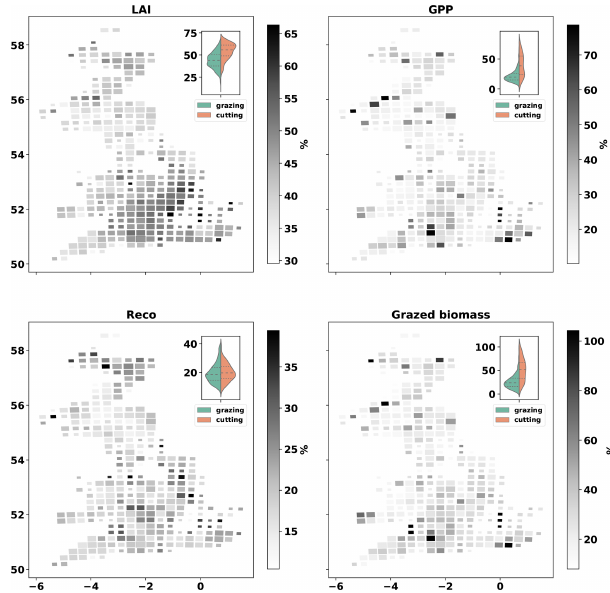
Figure 9. Cartograms of relative confidence range (RCR, 100 × CI / mean) of MDF-predicted LAI, GPP, Reco and grazed biomass. The mean across all fields in each cell is presented. The size of cells is adjusted according to the number of simulated fields within it. The violin-plot insets present the distribution of MDF esti- mates grouped according to the relative contribution of grazing and cutting to the total annual biomass removal (GCD). The green side of each violin plot shows results for fields in which most biomass was removed via grazing (GCD > 0). The orange side shows re- sults for fields in which most biomass was removed via cutting (GCD <